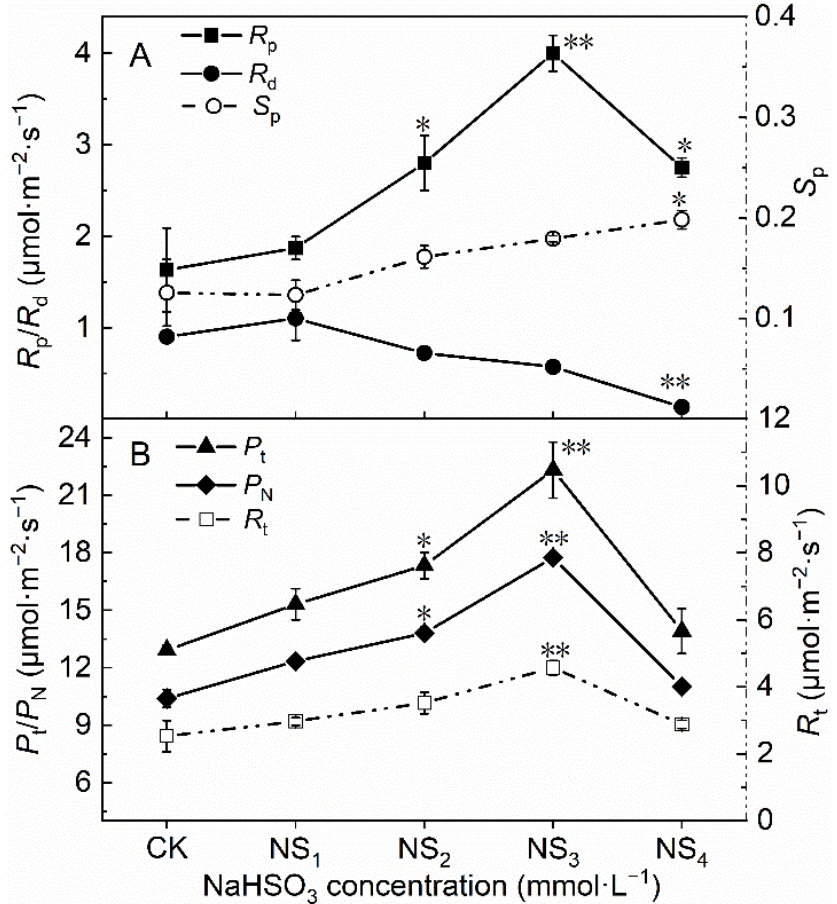
Figure 3. Photorespiration related parameters (( A ): R p , R d and S p ; ( B ): P t , P N and R t ) under different concentrations of NaHSO 3 . Significant differences between the control and treatment groups are indicated by asterisks (* p < 0.05, ** p < 0.01). R d : the dark respiration rate; R p : the photorespiration rate; R t : the total respiratory rate.